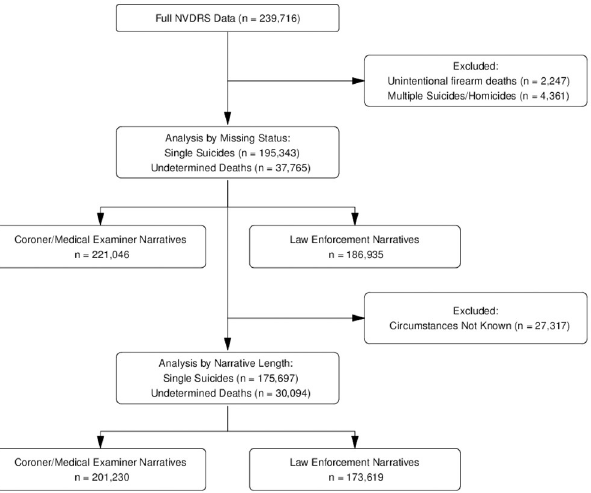
Fig 1. Flowchart of sample inclusion/exclusion criteria for analyses of narrative texts, National Violent Death Reporting System, 2003–2017.